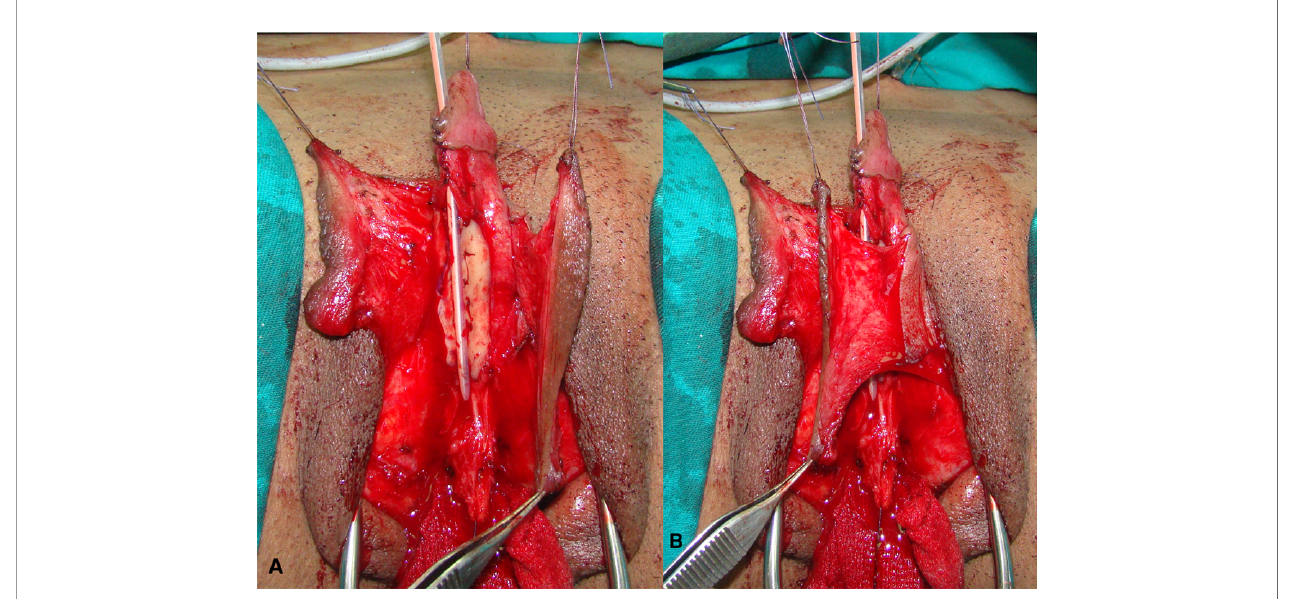
FIGURE 7 | Buccal mucosa graft is used for urethral substitute (A) ; left labial fl ap with abundant vascular pedicle is used as an anterior part of the neourethra (B) .